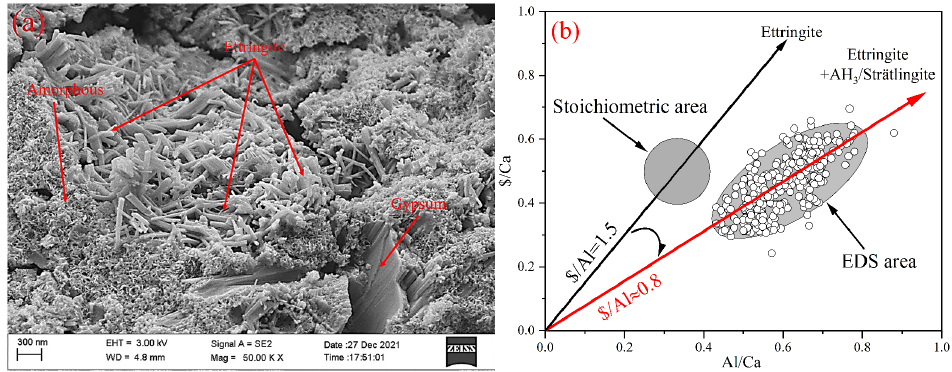
Figure 8. ( a ) SEM images of the hydration products of BYTC-2 formed after 7 d (on fractured surfaces); ( b ) Al/Ca and $/Ca molar ratios as determined by EDS analysis.